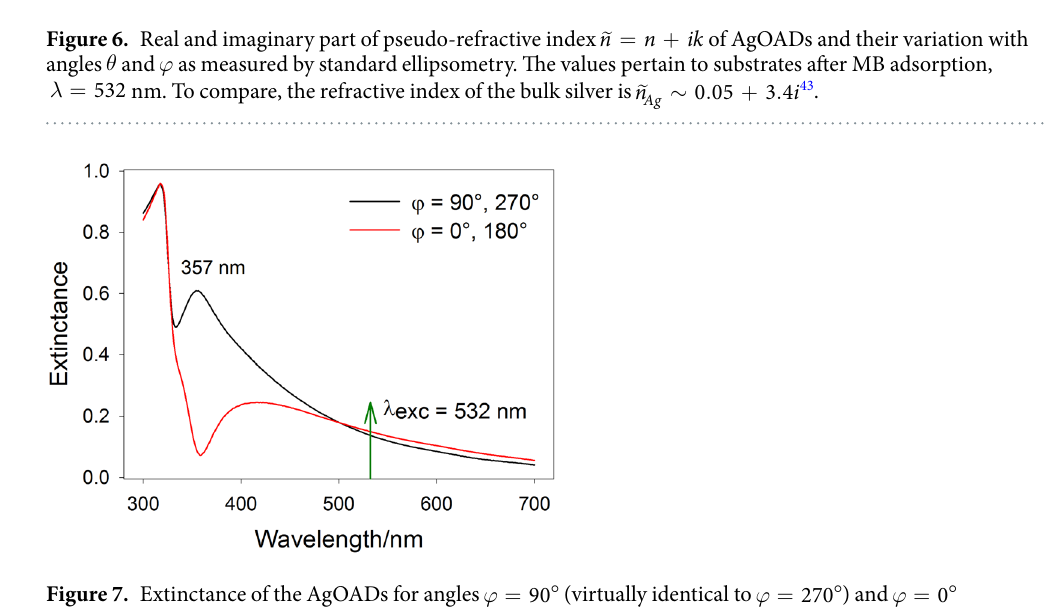
Figure 7. Extinctance of the AgOADs for angles ϕ = ° 90 (virtually identical to ϕ = ° 270 ) and ϕ = ° 0 (virtually identical to ϕ = ° 180 ). Extinctance ( E ) was calculated as = − E R 1 , where the reflectivity R was obtained based on the values = +  n n ik from Fig. 6. The exciting wavelength is marked with a green arrow, the angle θ was